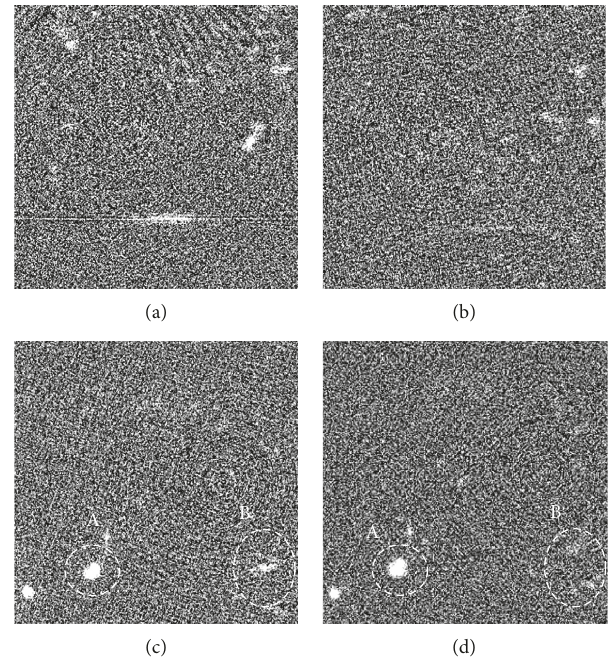
Figure 6: CT image of the inner structure of anthracite with a diameter of 2.54mm before and after modification. (a) Unmodified anodic zone, (b) modified anodic zone, (c) unmodified cathodic zone, and (d) modified cathodic zone.